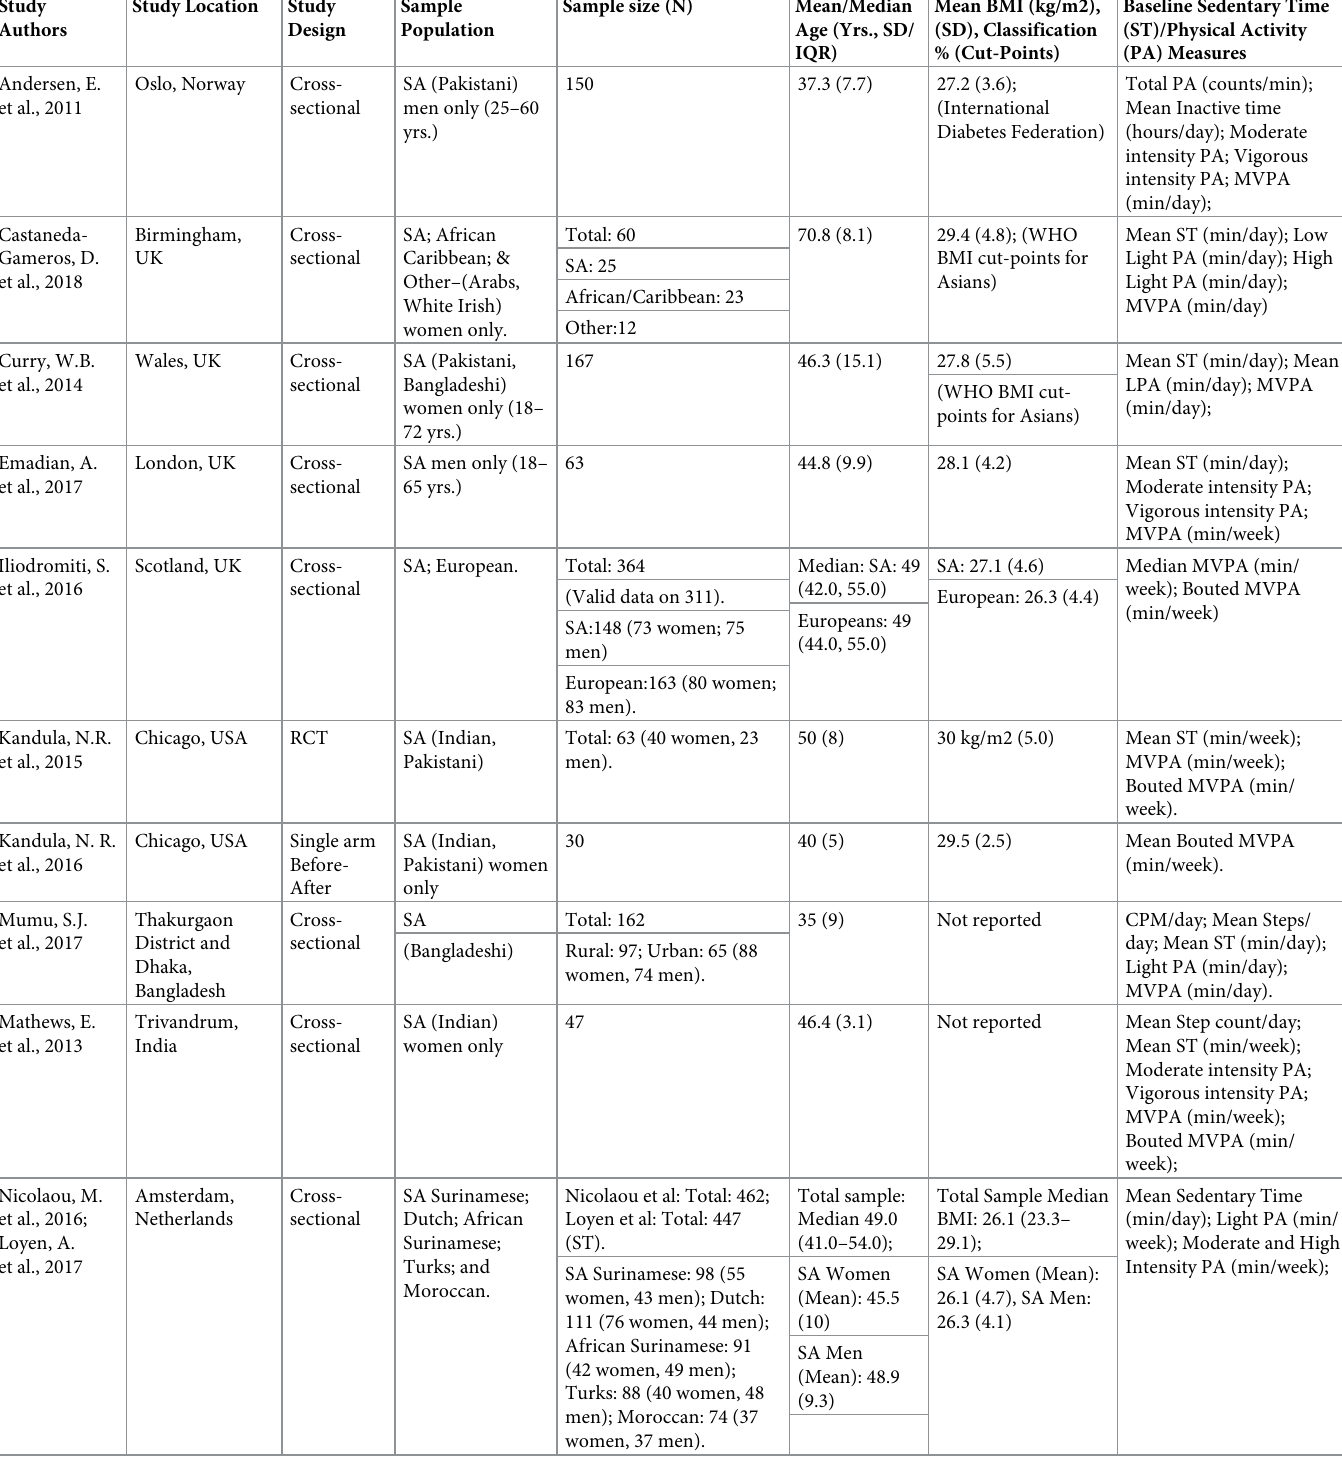
Table 1. Study and sample population characteristics included in the